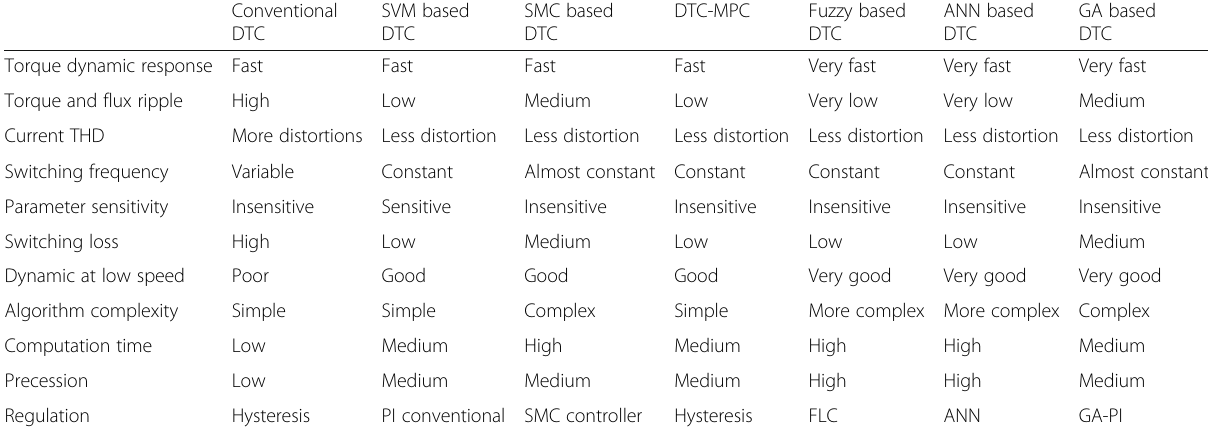
Table 2 Critical analysis of the improvement techniques of direct torque control [29, 34, 53 – 55, 73, 116, 118 –